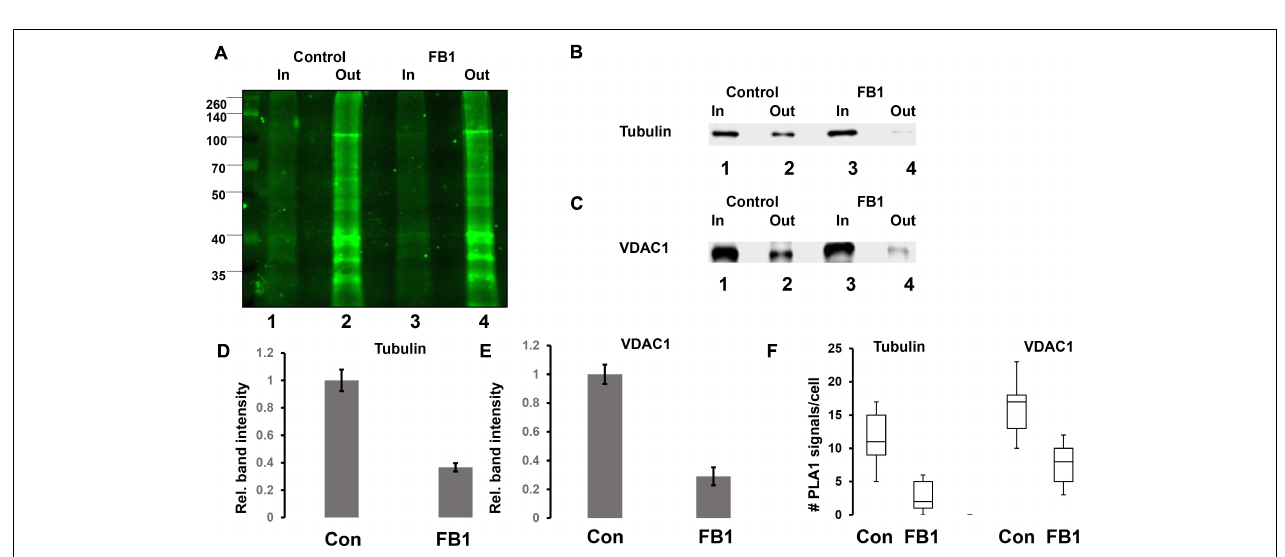
FIGURE 5 | PLA1 reaction using antibodies against VDAC1 and Alexa Fluor 647. (A) Primary cultured astrocytes were subjected to the PLA1 reaction (fluorescence signals for complexes of VDAC1 with Alexa Fluor 647-pacFACer are pseudo-colored in red) and then post-incubated with Alexa Fluor 488-conjugated anti-rabbit IgG to visualize mitochondria (pseudo-colored in green). Cross-linked pacFACer (conjugated to Alexa Fluor 647) is pseudo-colored in blue. (B) Detail from (A) shows mitochondria with VDAC1 cross-linked to pacFACer.